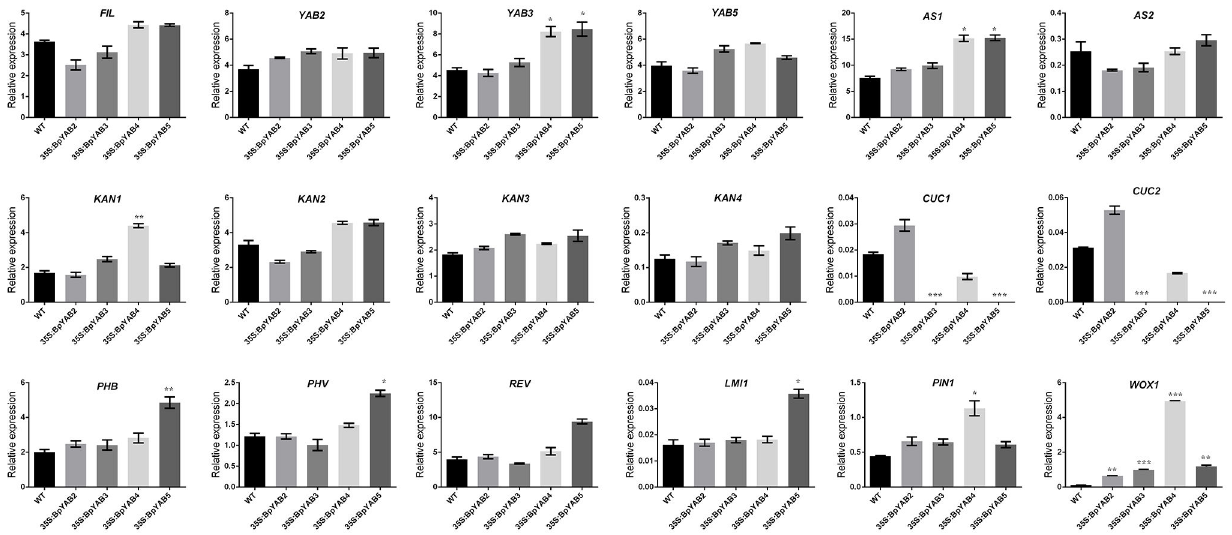
Figure 7. Expression of leaf-development-related genes in A. thaliana by ectopic expression of BpYAB2 , BpYAB3 , BpYAB4 , and BpYAB5 . * means p less than 0.05, ** represents p < 0.01 and *** represent p < 0.001. All the gene IDs and primers are listed in Table S5.